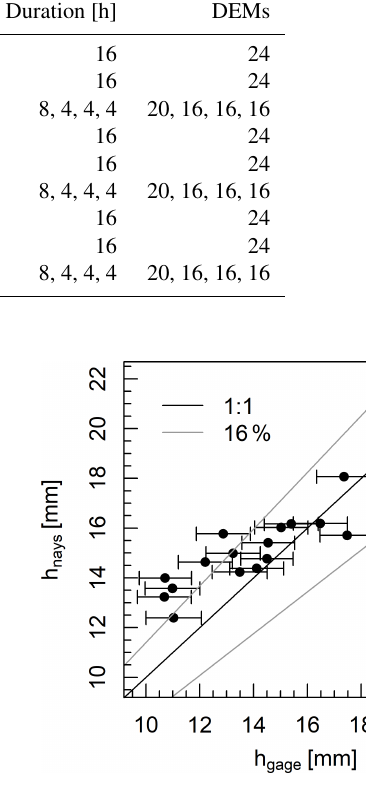
Figure 2. Measured versus modelled mean hydraulic depth h (i.e. reach-averaged) at the end of each experimental phase, featur- ing 16% bounds. Error bars are based on the measurement precision of the stream